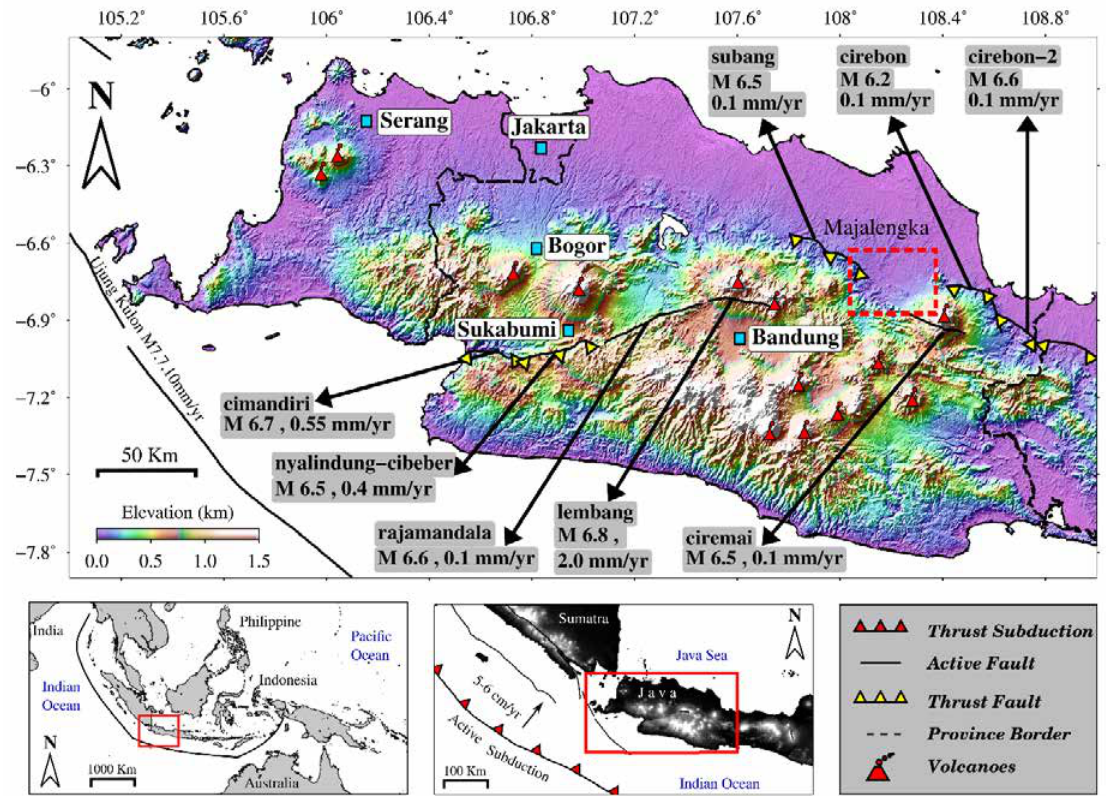
Fig. 1: (a) Geographical map of Indonesia and its surrounding with the study area (red square). (b) Seismicity map of West Java with the last decade’s earthquake distribution; the volcano locations were obtained from Sparks et al. (2012). (c) The study area with the observation points of HVSR and MASW. The map is plotted using generic mapping tools (GMT) (Wessel et al. 2019); the fault lines were obtained from Irsyam et al. (2017).